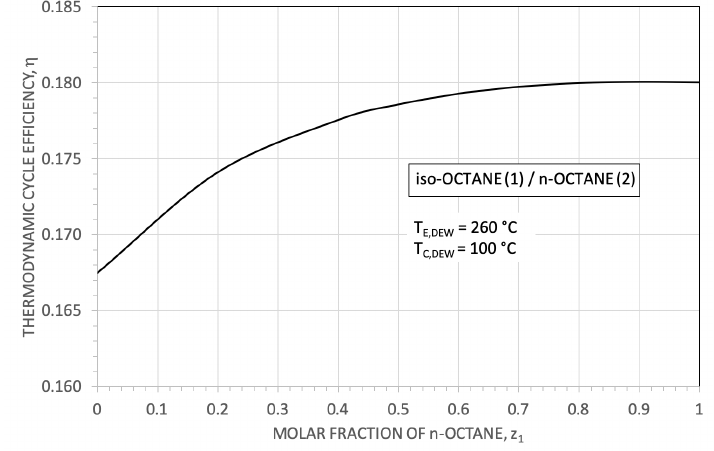
Figure 12. Thermodynamic cycle efficiency for the mixture iso-octane/n-octane as a function of the molar fraction of n-octane. The considered cycles are all subcritical with saturated